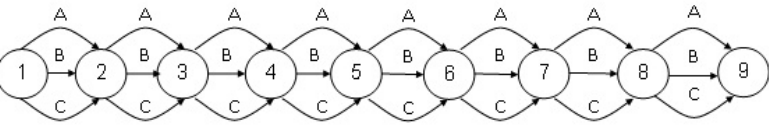
Figure 2. The JSS graph for the proposed ACO application scheme.